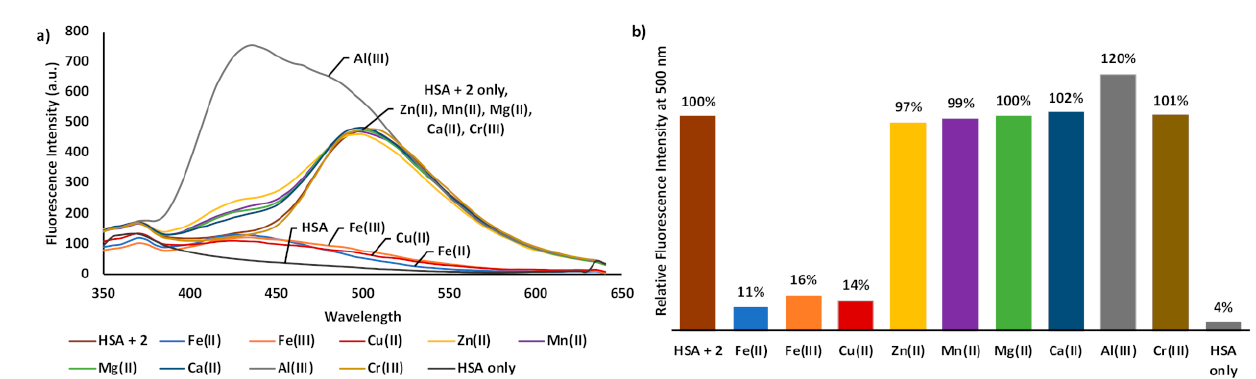
Figure 9. ( a ) Fluorescence emission profiles of 10 µ M 2 and 20 µ M HSA in the presence of 20 µ M of various test di- and trivalent metal cations in deionized water. ( b ) Relative fluorescence intensity at 500 nm for each metal cation